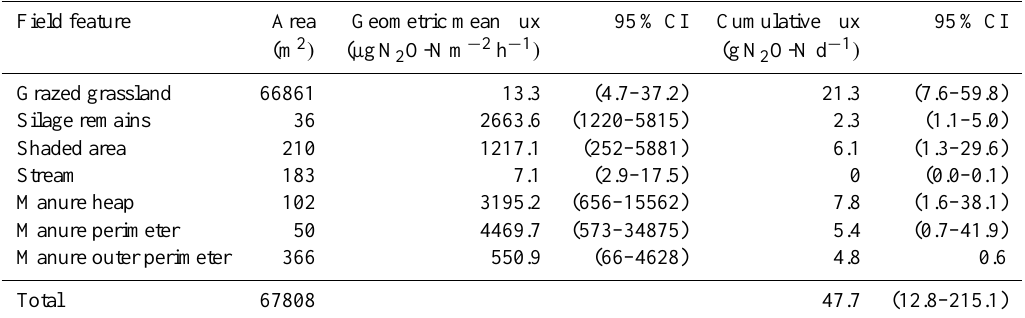
Table 3. Geometric mean flux values and estimated cumulative flux from each of the measured features across the field scale. 95% confidence intervals (CIs) are